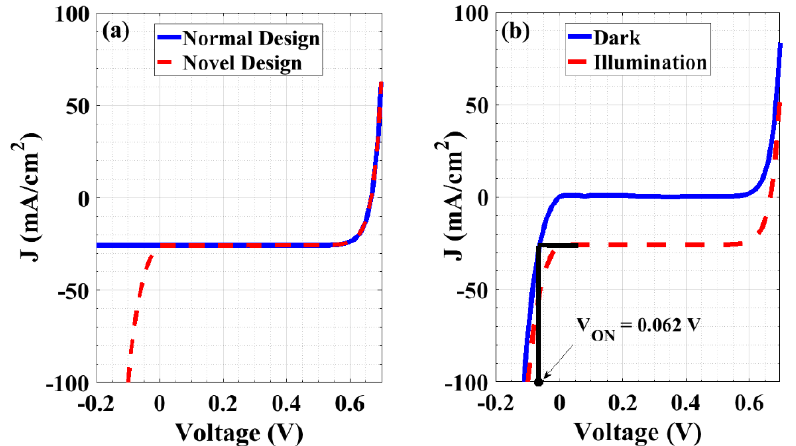
Figure 5. ( a ) Comparison of the electrical performance under an illumination condition for both the normal and novel structures, and ( b ) determining ON-state voltage of the proposed cell.